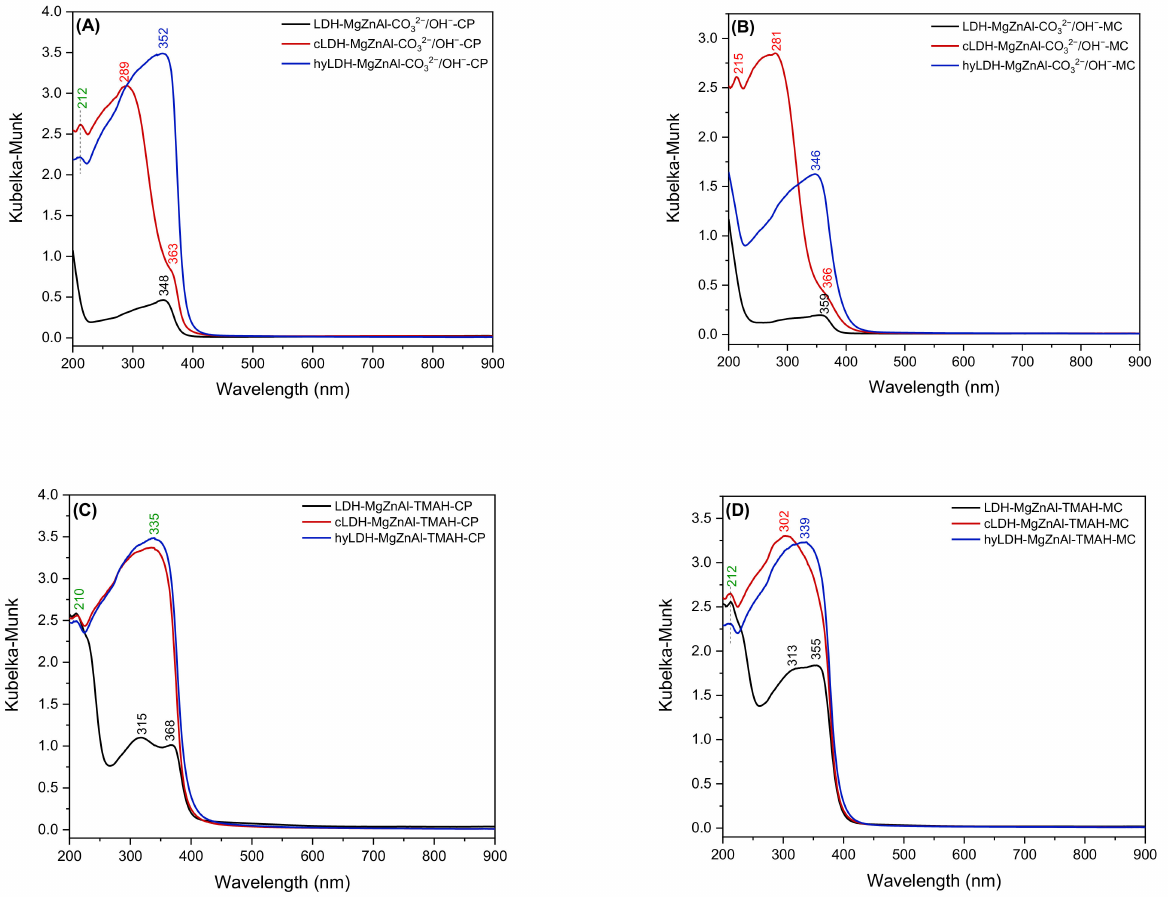
Figure 3. UV–VIS spectra of the materials synthesized though ( A ) co-precipitation and ( B ) mechano- chemical method, both in the presence of Na 2 CO 3 /NaOH, as well as ( C ) co-precipitation and ( D ) mechano-chemical method, both in the presence of